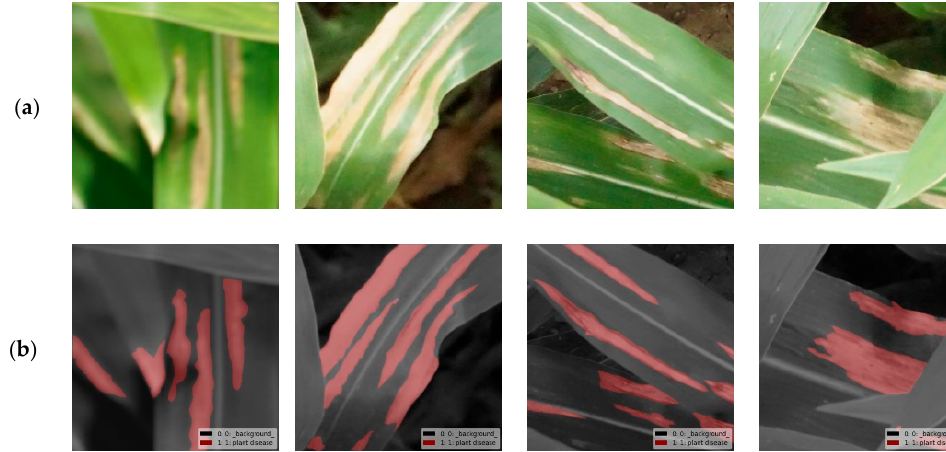
Figure 2. Reference of maize images and their corresponding labels. ( a ) cropped images, ( b ) la- beled images beled